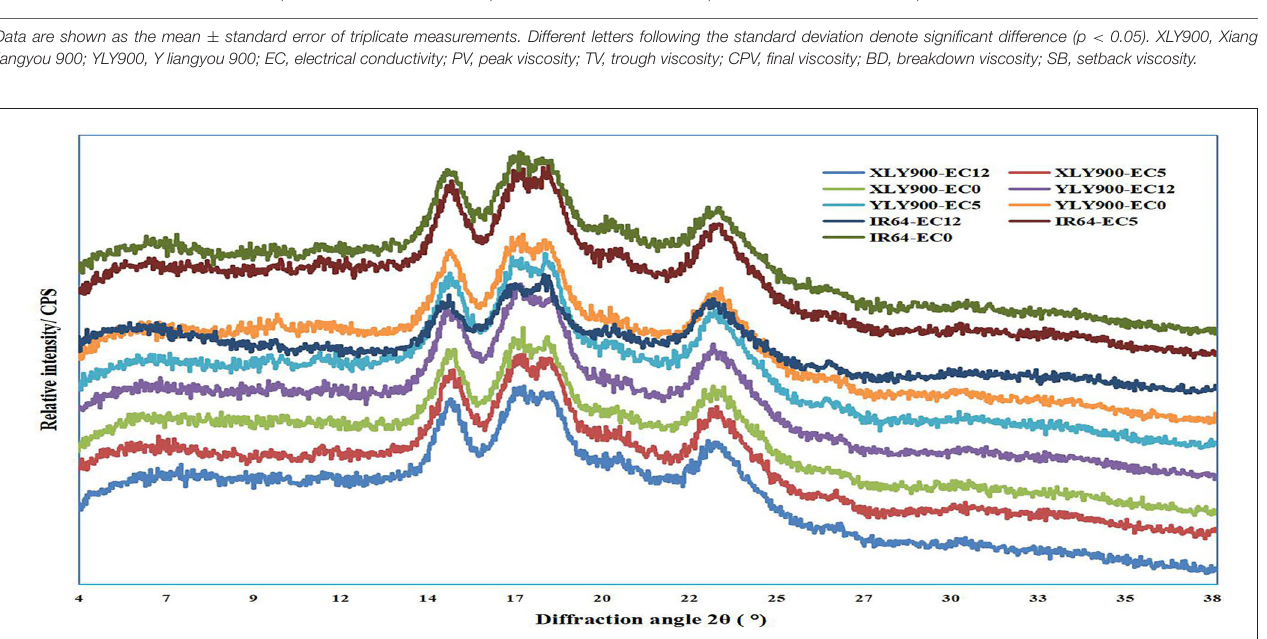
FIGURE 2 | Effects of salt stress on the X-ray diffraction patterns of rice starch. XLY900, Xiang liangyou 900; YLY900, Y liangyou 900; EC12, EC5, and EC0 represent that the electrical conductivity is 12, 5, and 0–1 dS/m,